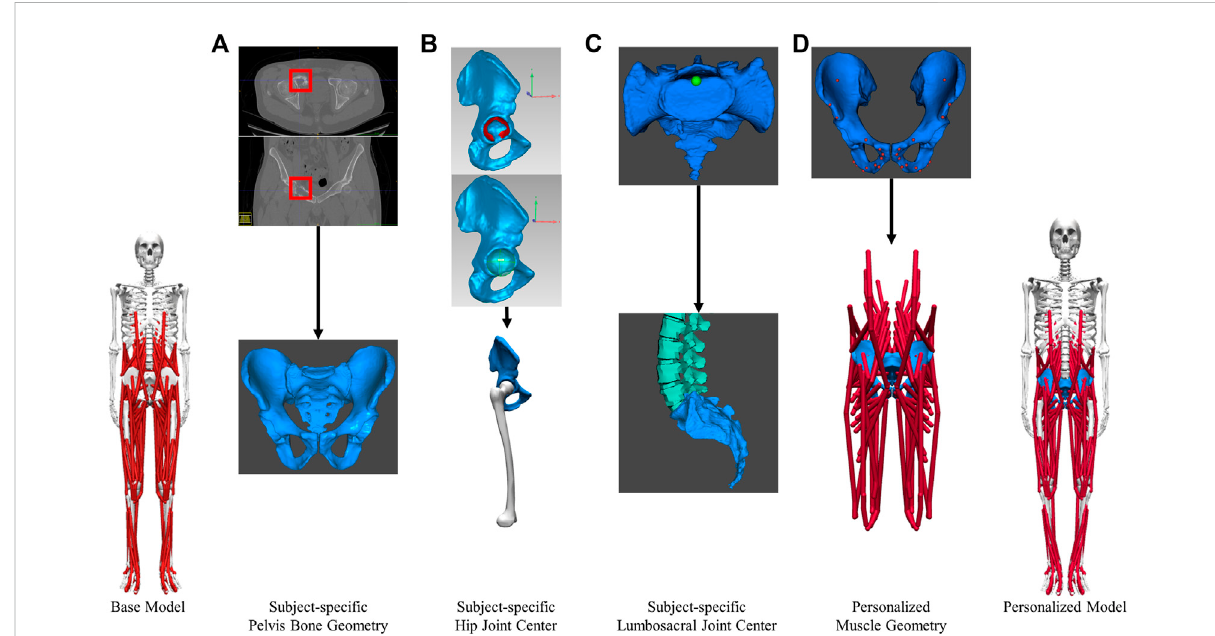
FIGURE 2 Image-based modeling approach to create subject-speci fi c musculoskeletal model for the pelvic region. (A) segmenting CT scan images to obtain pelvis bone geometry. Tumor growth was highlighted by the red boxes (B) Determining the hip joint center (C) Determining the lumbosacral joint center. (D) Creating personalized muscle